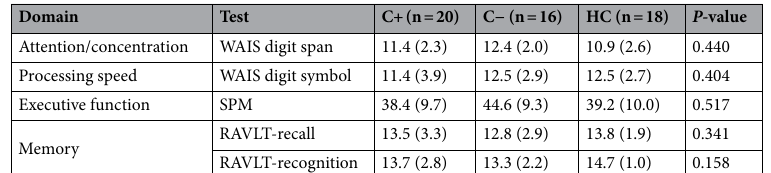
(Fig. 1, Table 3). FC analyses without covariates were performed because the analyses with covariates had low statistical power due to small sample sizes. Both methods yielded similar results (Supplementary Table S1). Correlation analysis between neurocognitive performance and FC in breast cancer patients. In breast cancer patients with cognitive complaints (n = 36), the FC of the DLPFC-lobule VII was negatively correlated with executive function ( r = − 0.38, P = 0.026) (Fig. 2A). For FC of the DLPFC-vermis XI, attention/concentration was inversely correlated ( r = − 0.34, P = 0.044) (Fig. 2B). When the correlation analysis was adjusted for the scores of depression and anxiety, the correlation between FC of the DLPFC-lobule VII and executive function ( r = − 0.36, P = 0.039) remained.